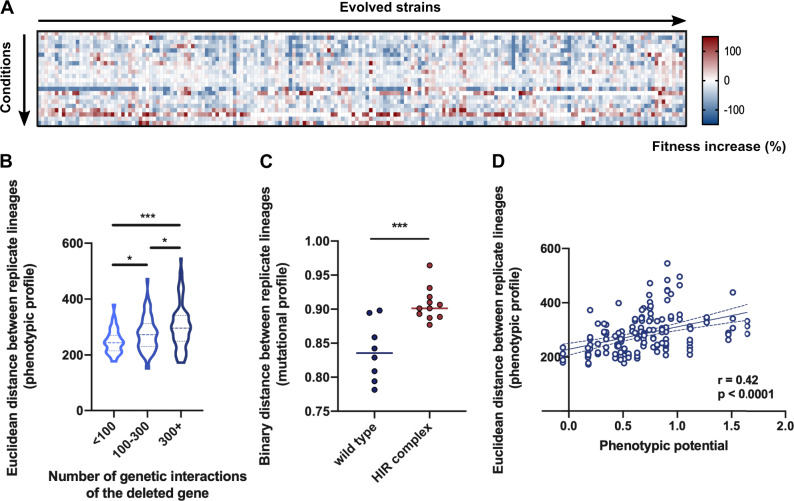
Adaptation after losing genes with more interaction partners results in a higher phenotypic variability between independent lineages. (A) Heat map with the fitness increase (%) of the evolved strains (columns) across 22 different phenotypic conditions (rows). Red hues indicate a fitness increase as compared with the corresponding strain before evolution and blue hues indicate a decrease in fitness. (B) Phenotypic distance between replicate lineages in function of the number of genetic interactions of the deleted gene. A high value for the phenotypic distance corresponds with more variation between the phenotypic profiles of the replicate lineages of a particular deletion strain. *P < 0.05, ***P < 0.001 (Student’s t-test). (C) Mutational distance between replicate lineages of the wild-type strains compared with strains lacking genes from the HIR complex. The mutational profile is defined by the genes and GO categories that were mutated after evolution. A high value for the mutational distance corresponds with more variation between the mutational profiles of the replicate lineages of a particular deletion strain. ***P < 0.001 (Student’s t-test). (D) Phenotypic distance between replicate lineages in function of phenotypic potential, as determined in Levy and Siegal (2008). The phenotypic potential represents the overall phenotypic variation when a gene is deleted. Lines represent the best linear fit with its 95% confidence interval.